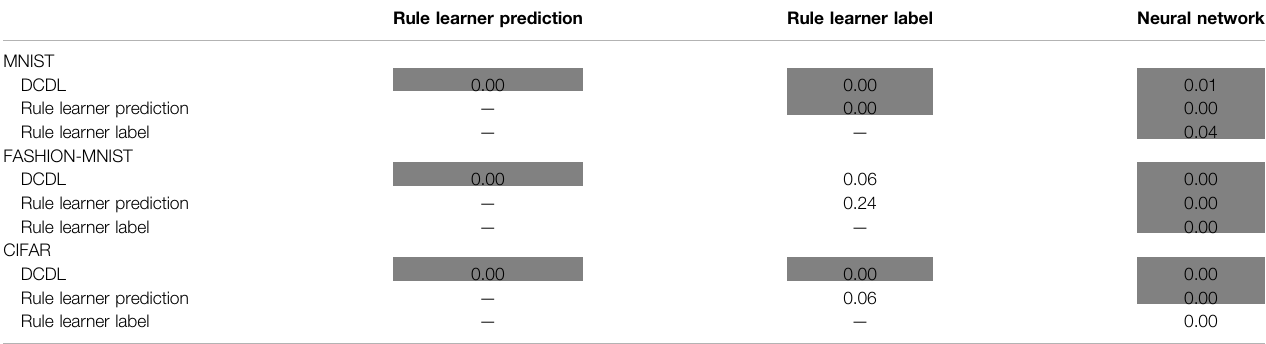
TABLE3| Shownare p -valuesofthecorrectedresampled t -test(NadeauandBengio,2003)forMNIST,FASHION-MNISTandCIFARwithdecisiontreenormallabelsforthe accuracyvaluesplottedin Figure5 .Gray-shadedarethepairsforwhichthenullhypothesisisrejectedwithsigni fi cancelevel α (cid:2) 0 . 05usingacorrectedresampled t -test (Nadeau and Bengio,